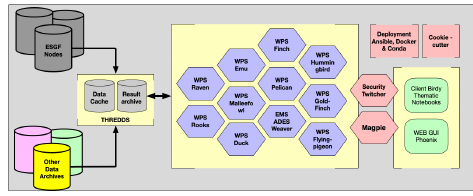
Figure 2. Example repositories of the birdhouse GitHub organisation: OGC Standard based building blocks for